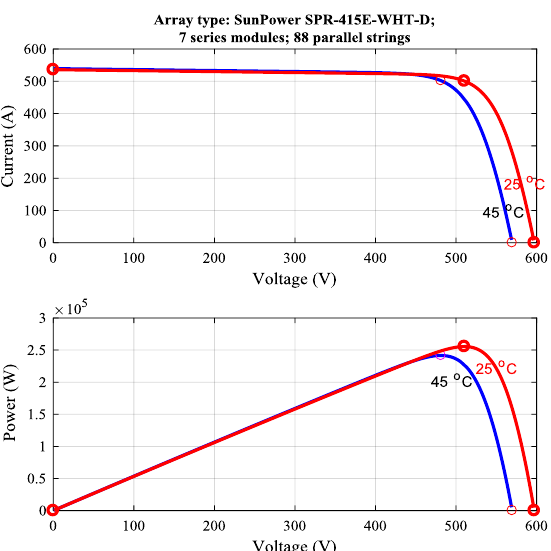
Figure 8. Volt-ampere curve and characteristic PV array power curve